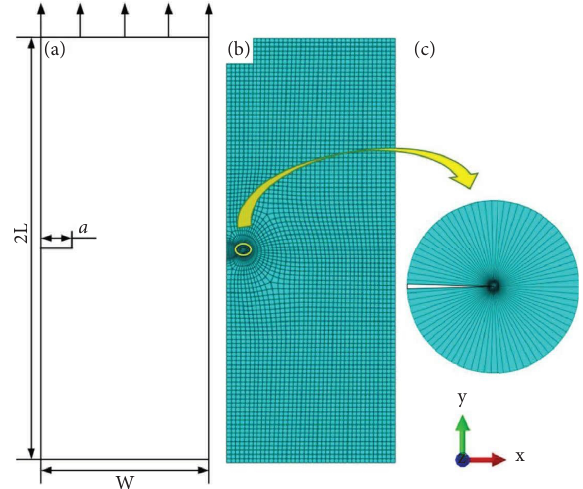
Figure 3: Finite element model: (a) fnite element geometry model; (b) global fnite element mesh; (c) mesh around the crack tip.